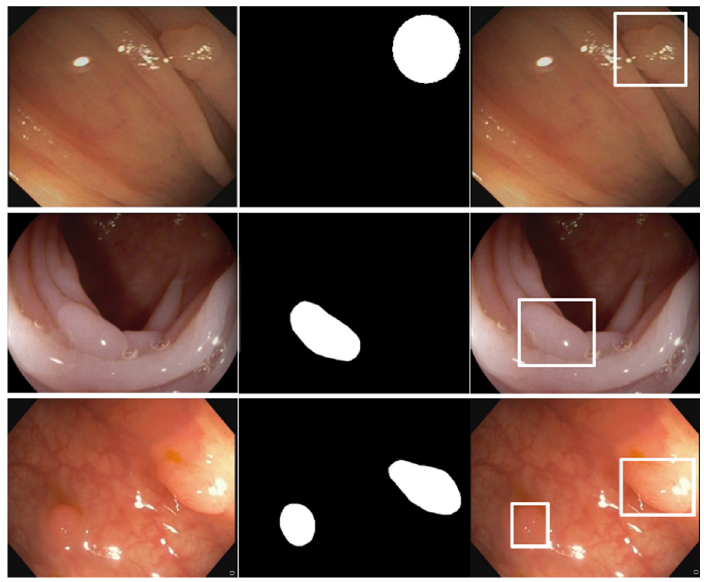
Figure 3. Conversion from binary mask annotations to bounding boxes. First column: original polyp images. Second column: binary mask annotations. Third column: obtained bounding box annotations over the original polyp